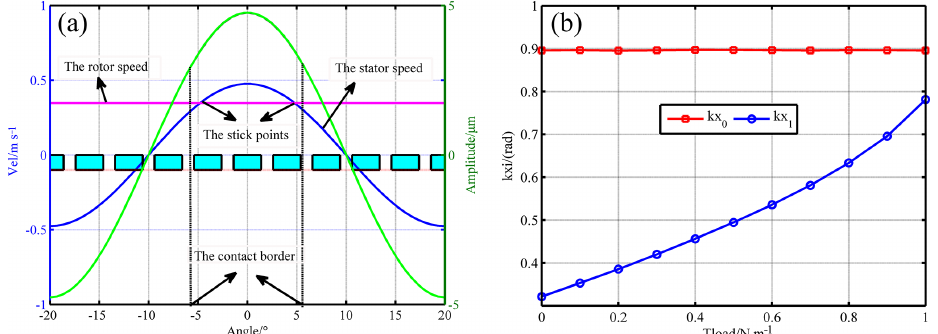
Figure 7. The contact status: (a) the external torque is 0.5Nm; (b) the contact parameters under different torques.